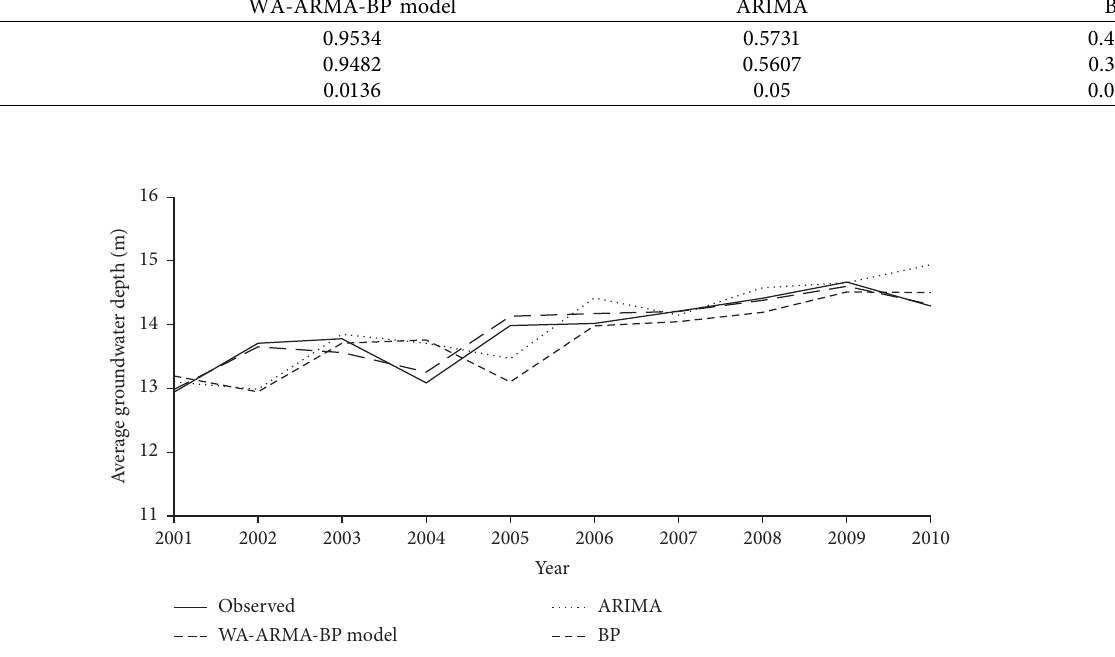
Figure 7: Comparison of observed and forecasted average groundwater depth for test period using WA-ARMA-BP model, ARIMA model, and BP neural network